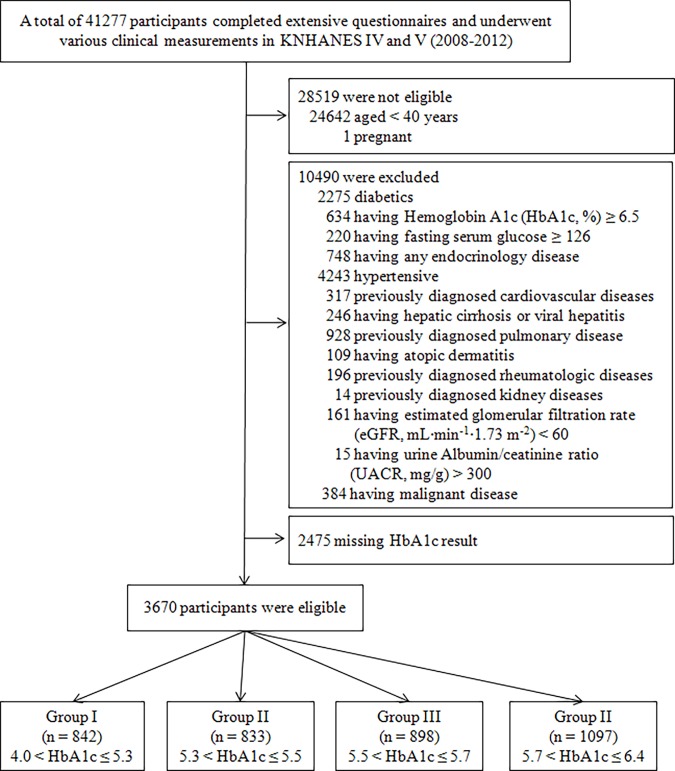
Flow chart of the study group enrollment process.KNHANES, Korean National Health and Nutritional Examination Survey.